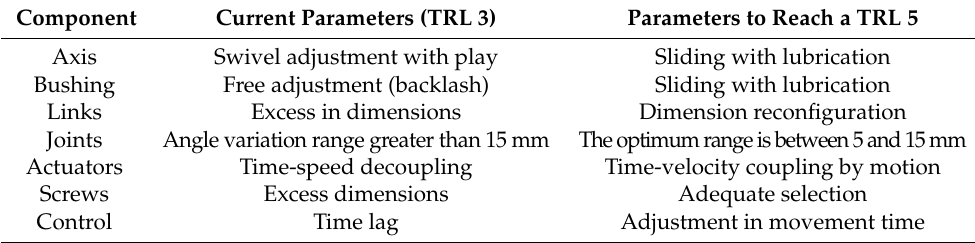
Table 9. Technological maturity of ERMIS.